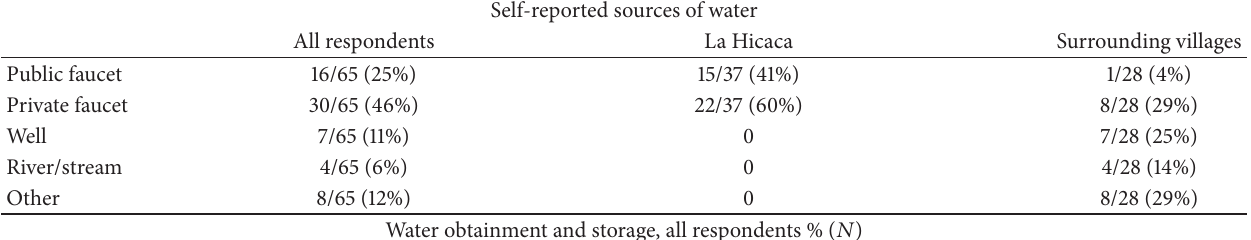
Table 2: Results.